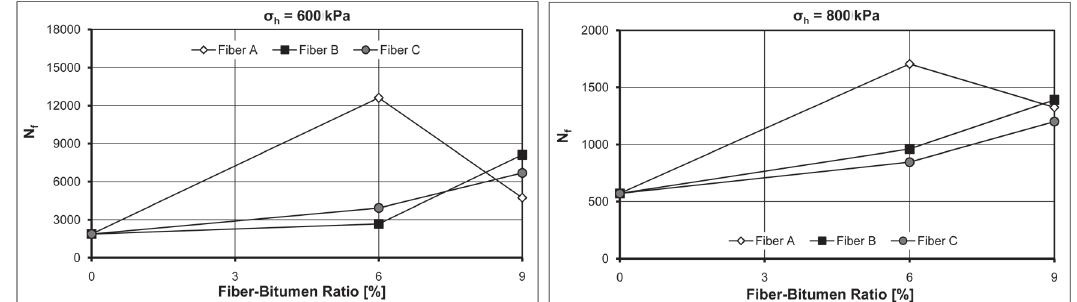
Fig. 12. Fatigue resistance of bituminous mixtures subjected to controlled stress test at 20